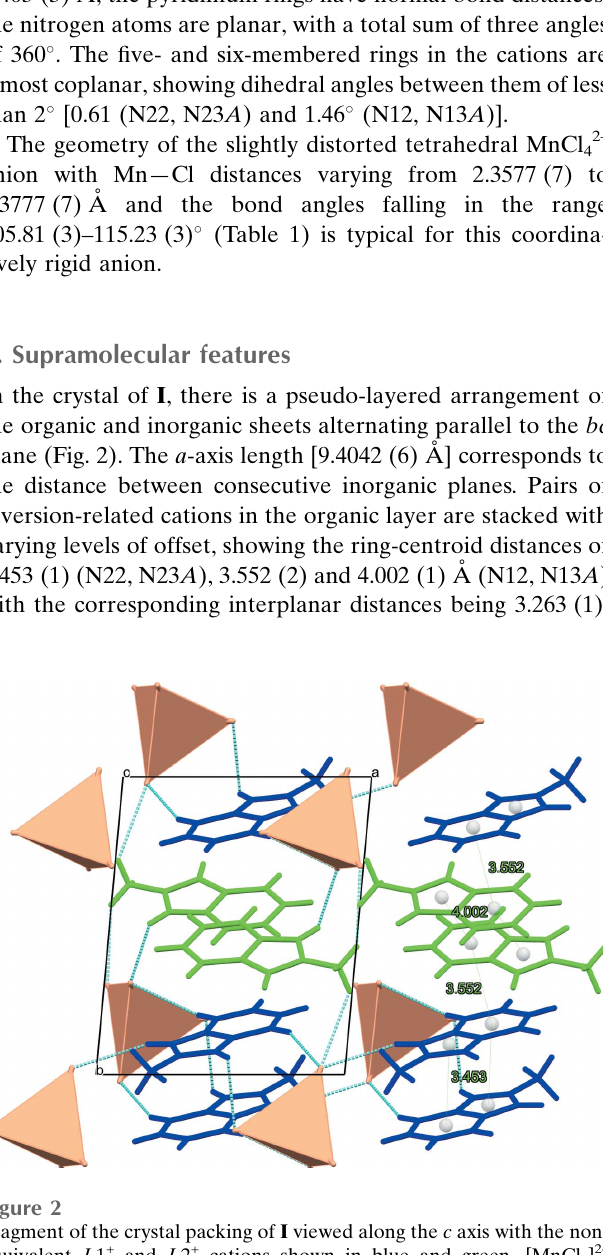
Figure 1 Molecular structure and atom labeling of [ L ] 2 [MnCl 4 ] ( I ), with 50% probability displacement